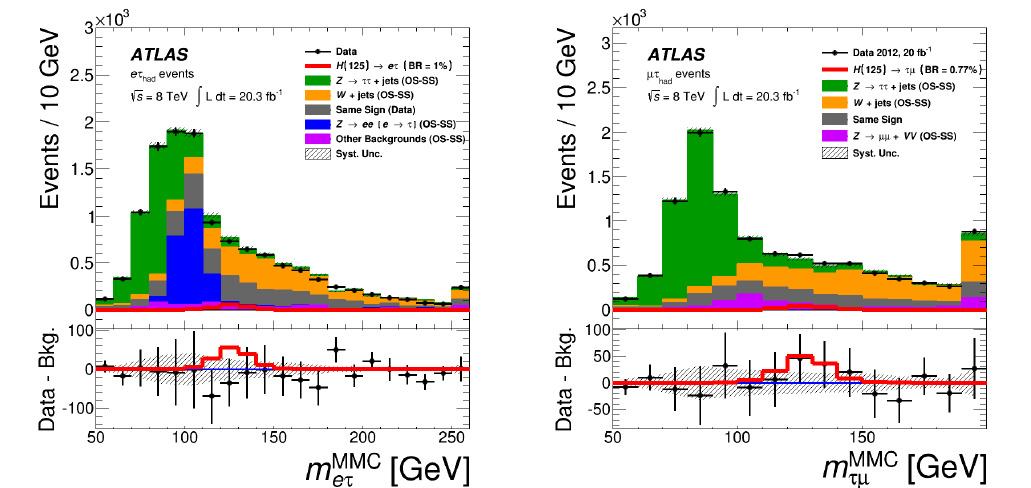
Figure 1: The distribution of the reconstructed di-tau mass in the H → e τ (left) [ 11 ] and H → µτ (right) [ 10 ] searches respectively. The lower panels quatify agreement between the background model and data, with the red line quantifies the agreement when considering the contribution from the